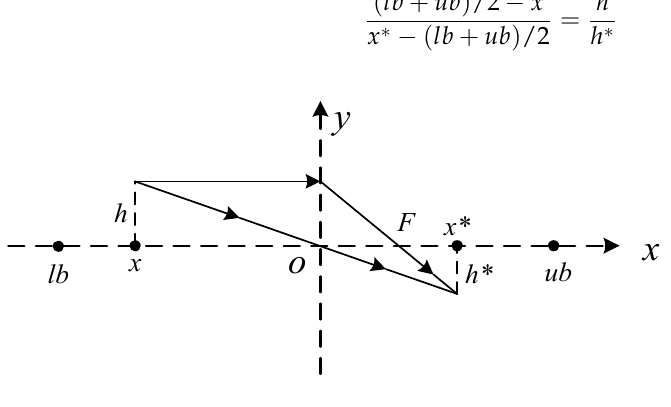
Figure 3. Diagram of LOBL.